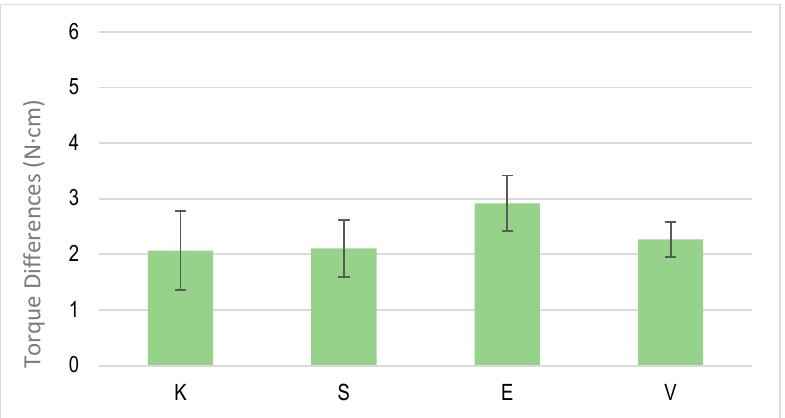
Figure 8. Torque differences for the cyclic test of tightening and untightening torque for each dental implant system. Once the dental implants were placed with their abutments, the RFA measurements were taken, obtaining mean ISQ values of 66 and 68 for the K and S dental implants, re- spectively. No statistically significant differences were observed in the values between the externally connected dental implants. However, the RFA values for the dental implants with an internal connection were 76 and 74 for the E and V implants, respectively. Among the dental implants with an internal connection, there were no statistically significant dif- ferences using, as in the previous case, values of p < 0.001. Statistically significant differ- ences were observed between the two types of internal and external connection, with sig- nificantly higher values for the internal connection. The values of the micromotion for each of the dental implants were obtained when a progressive load of 20 N was applied. It was observed that in all the systems, it increased in a linear way with the applied load and the micromotions were smaller when the ISQ was higher. The results for the K implants are shown in Figure 9, for the S implants in Figure 10, for the E implants in Figure 11, the results for the V bone level implants are shown in Figure 12.